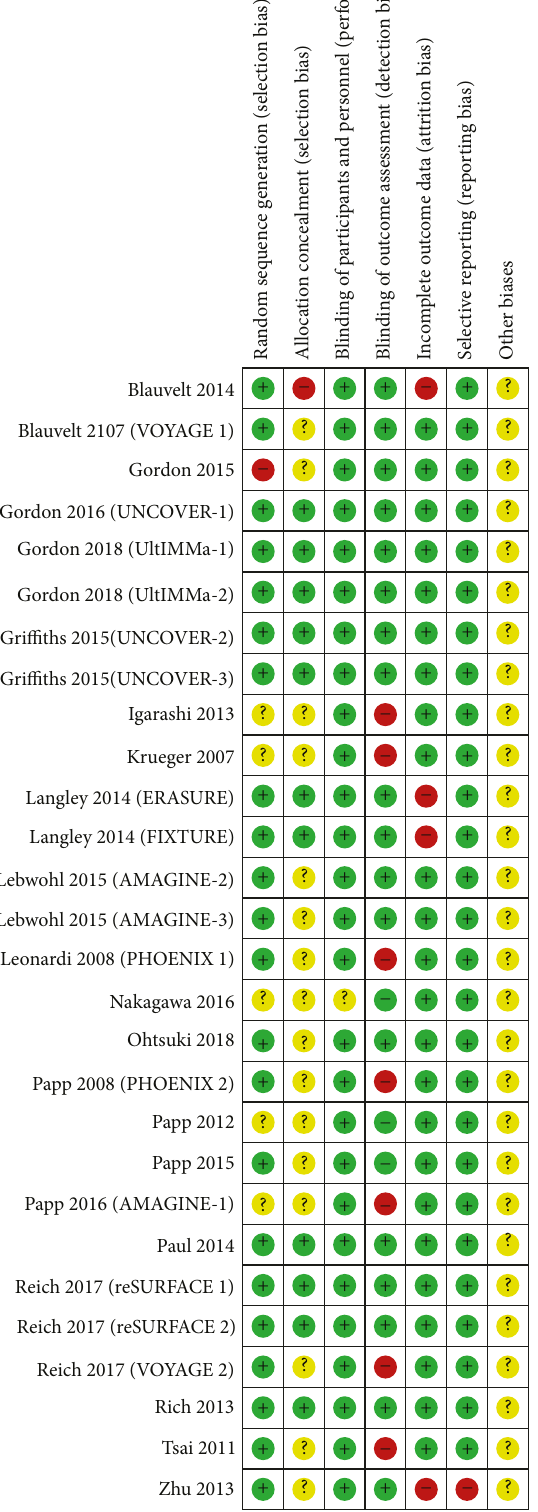
Figure 2: Risk of bias